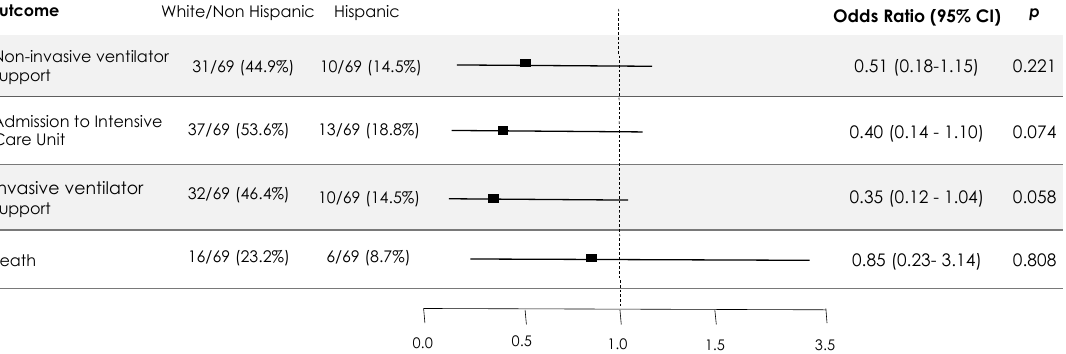
Figure 1. Main outcomes in a PSW multivariate analysis adjusted by residual confounding factors. Adjusted by immuno- suppression, ferritin level, troponin level, asthenia in the first assessment, tocilizumab use. Interleukin 6 and PaO2:FiO2 were excluded, due to the lack of information about them in more than 15% of the patients. WHO ordinary scale, which includes the outcomes evaluated, was also excluded.